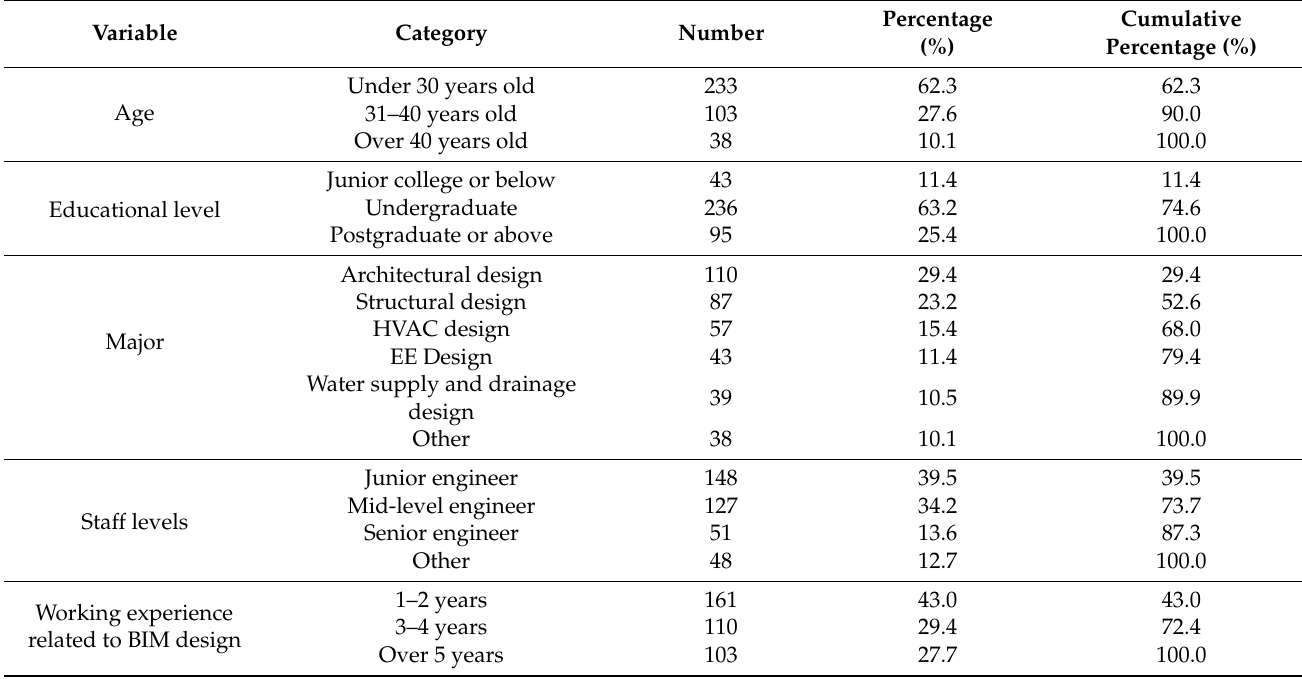
Table 2. Summary of respondent socio-demography ( n =